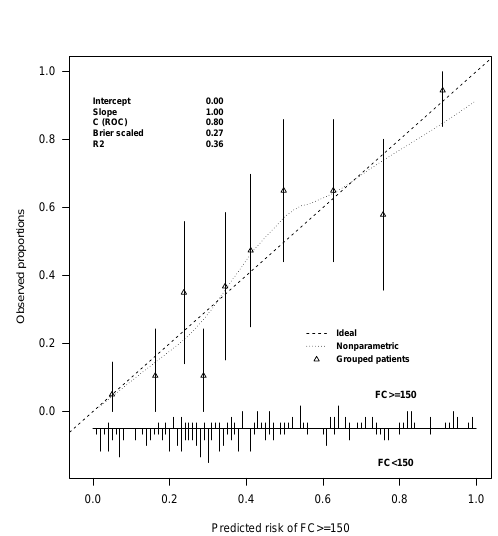
Figure 2 – Validation graph for the estimated model: ”Non-parametric” is a smoothed function of observed events plotted versus predicted probabilities; ”Ideal” is the ideal 45-degree line; triangles indicate the outcomes for deciles of prediction with their 95% confidence